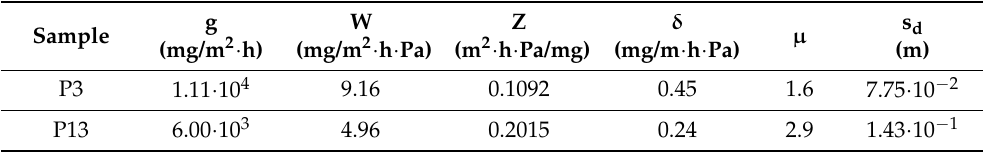
Figure 16. Short-term water absorption by partial immersion, W p , for samples P3 and P13.